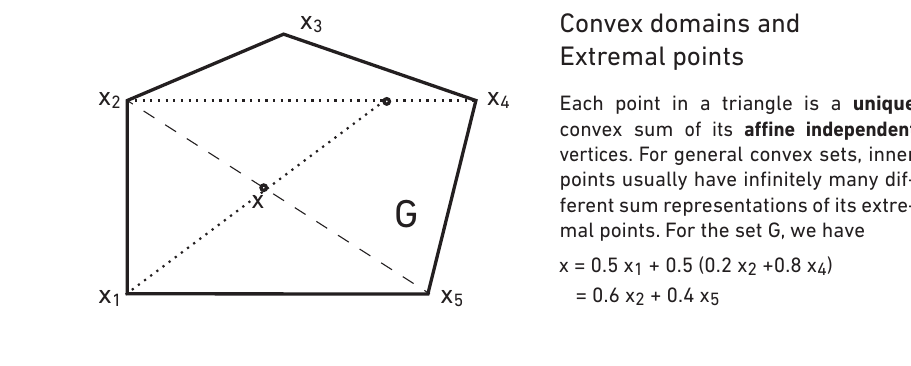
Figure 2: Minkowski’s Theorem in R 2